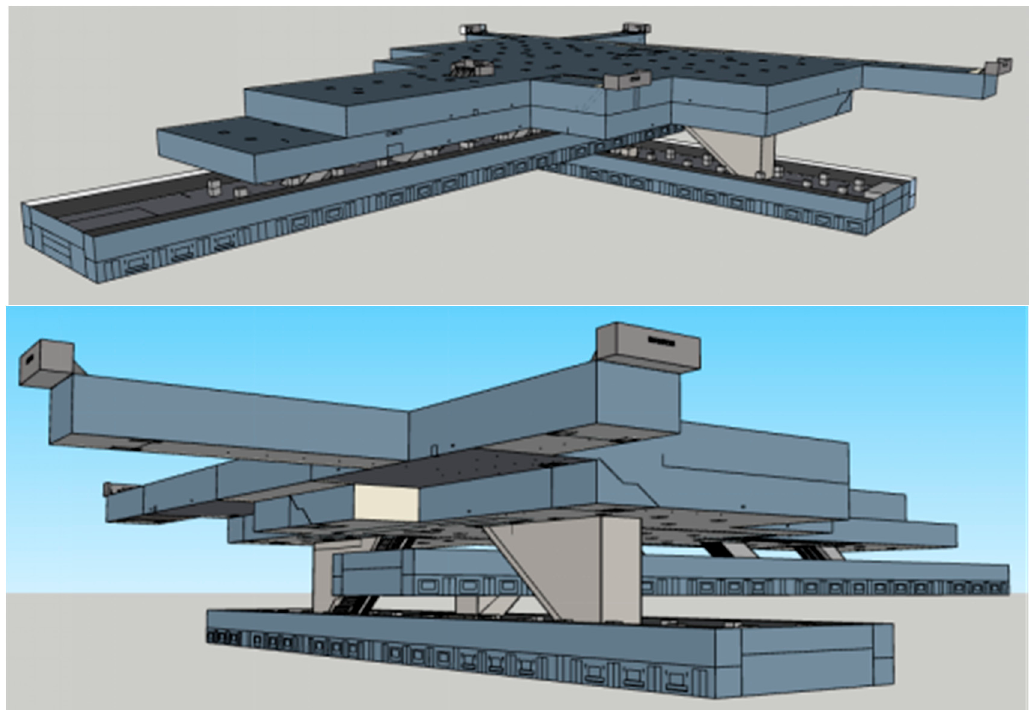
Figure 3. Screenshot of 3D model of Zijing Mountain subway station in SketchUp (1:1 scale of the real Zijing Mountain subway station).